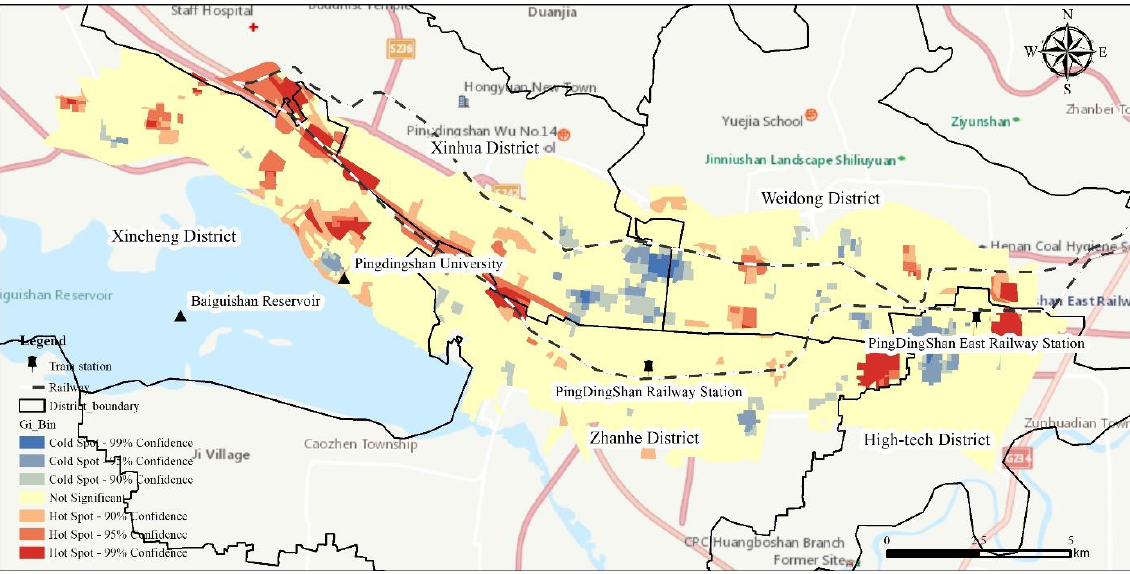
Figure 3. Fractal dimension index hot spot analysis of road enclosure patches in Pingdingshan city.